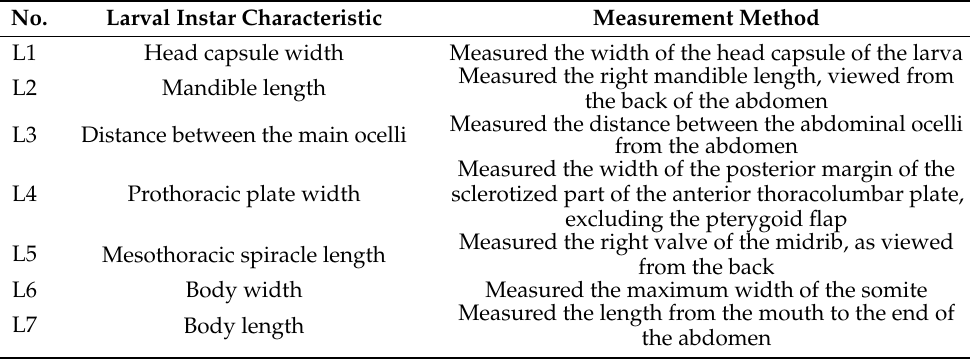
Table 1. Morphological variables of M. saltuarius